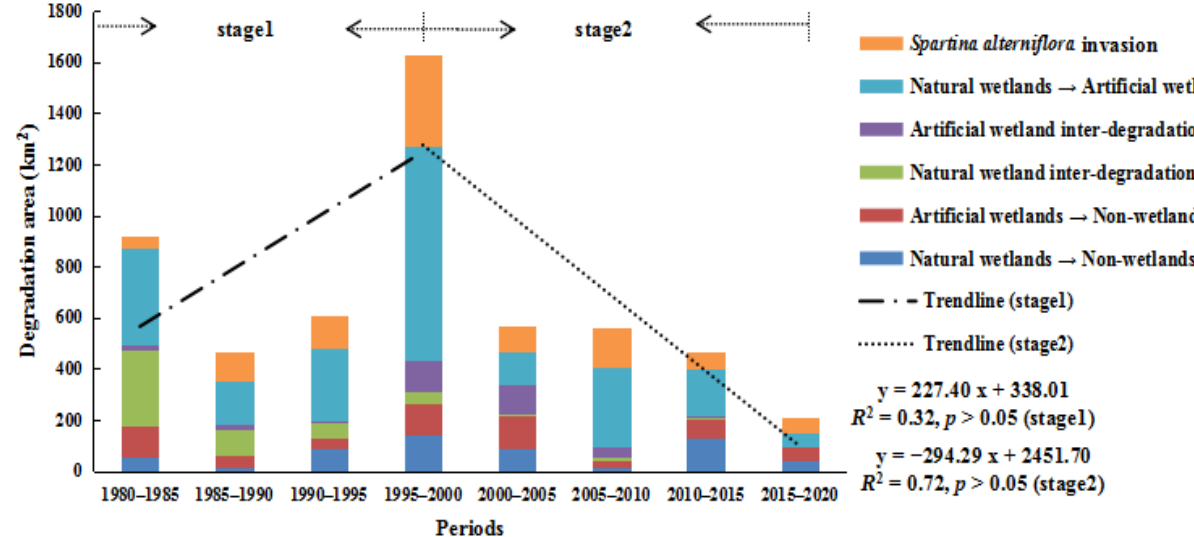
Figure 5. Degradation types of the coastal wetlands in different periods in northern Jiangsu, China.